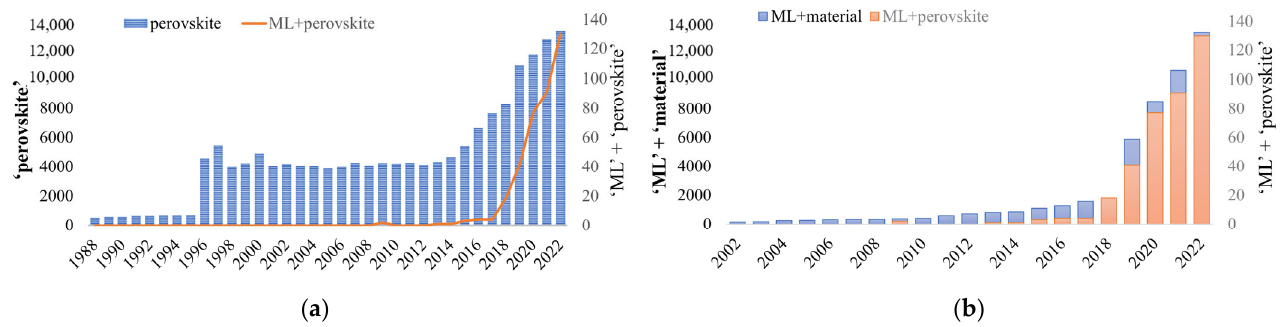
Figure 1. Number of published papers. ( a ) On the key words ‘perovskite’ and ‘machine learning and perovskite’ (from 1988 to 2022). ( b ) On the key words ‘machine learning and material’ and ‘machine learning and perovskite’ (from 2002 to 2022).